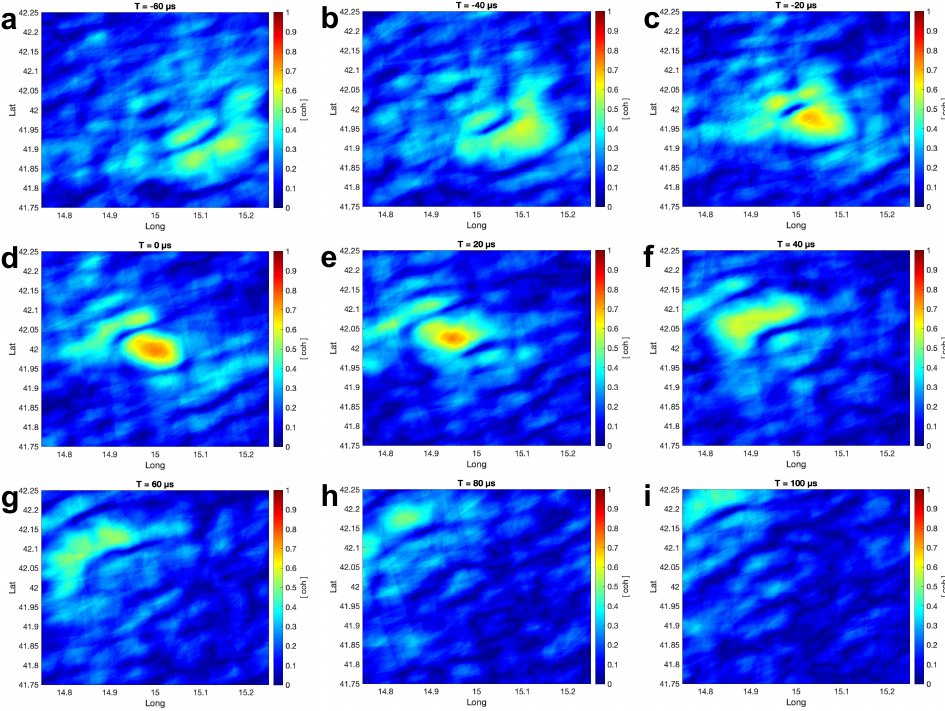
Figure 16. The coherency maps using the impulse response function filtered waveforms with a simulated lightning location of 15°E and 42°S. Each sub-figure ( a – i ) is the coherency map at a different